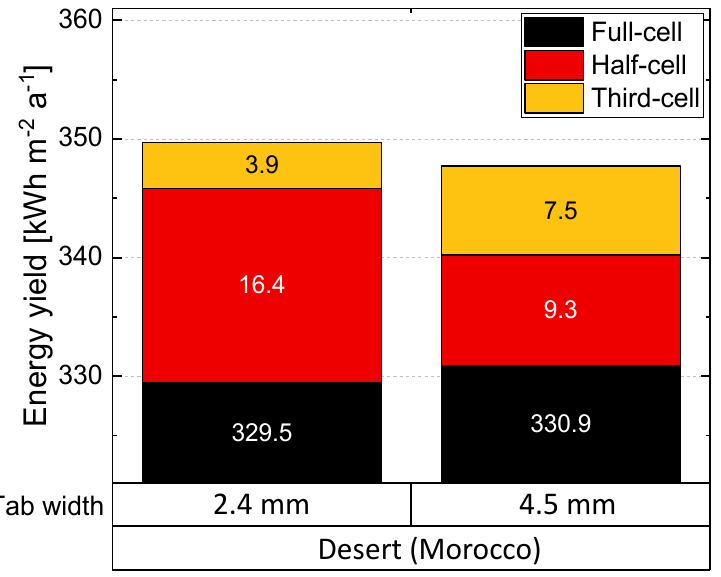
Figure 8. Cell-to-module power ratio of 100 PV modules (25 per each group) with full-cell and half-cell designs and two total tab widths of 2.4 mm and 4.5 mm.